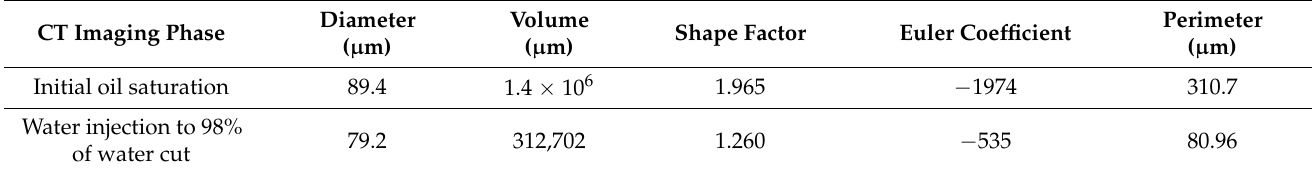
Table 2. Geometrical analysis of residual oil droplets in No. 2 rock sample.